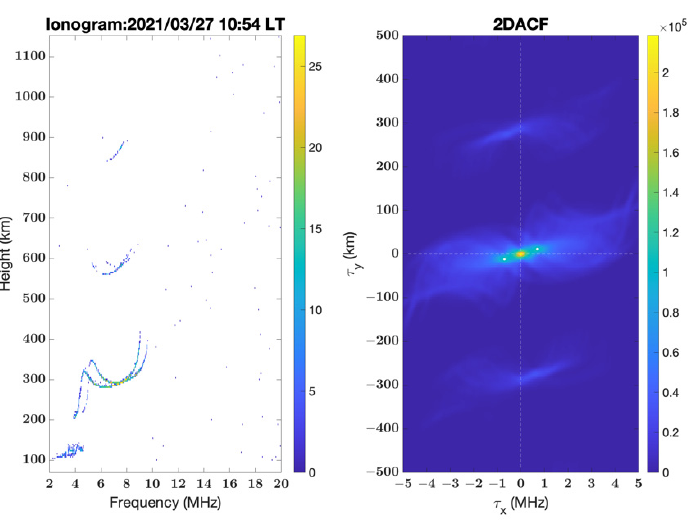
Figure 6. Example of the 2DACF ( right ) of the traces ( left ) in the ionogram. The contour represents the number of overlapped points, and τ x and τ y are, respectively, the horizontal (frequency) and vertical (virtual height) displacements of the traces. The yellow dot is the major peak of the 2DACF, and the two white dots on each side of the yellow dot mark the secondary minor peaks that resulted from the overlaps of the O- and X-wave traces. The horizontal separation between the major and minor peaks in frequency is equal to half of the electron gyrofrequency, which is about 0.7 MHz for the present case.